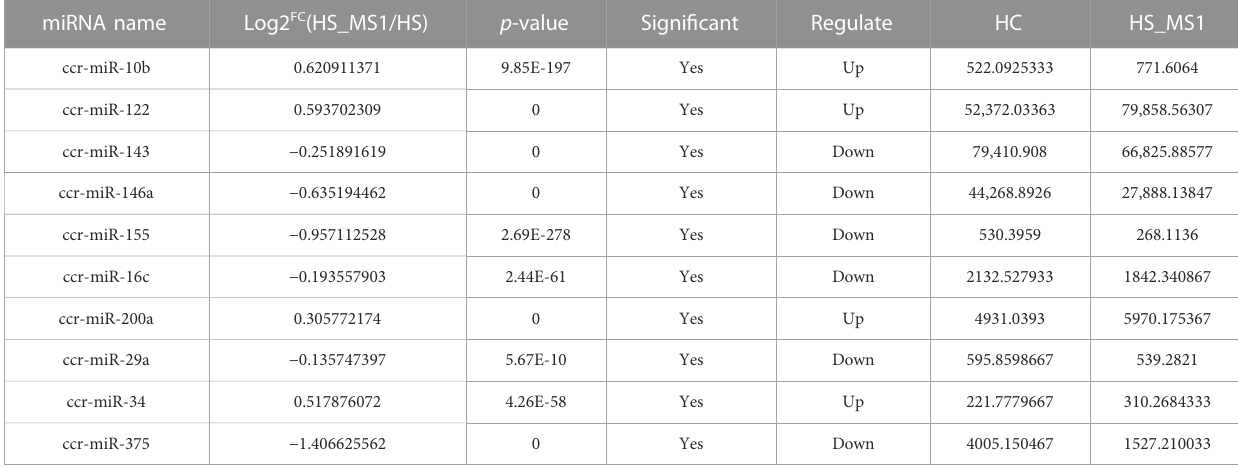
TABLE 5 Differential expression of miRNAs in HC and HS_MS2 groups associated with insulin signaling pathway and insulin resistance of common carp (n = 6).